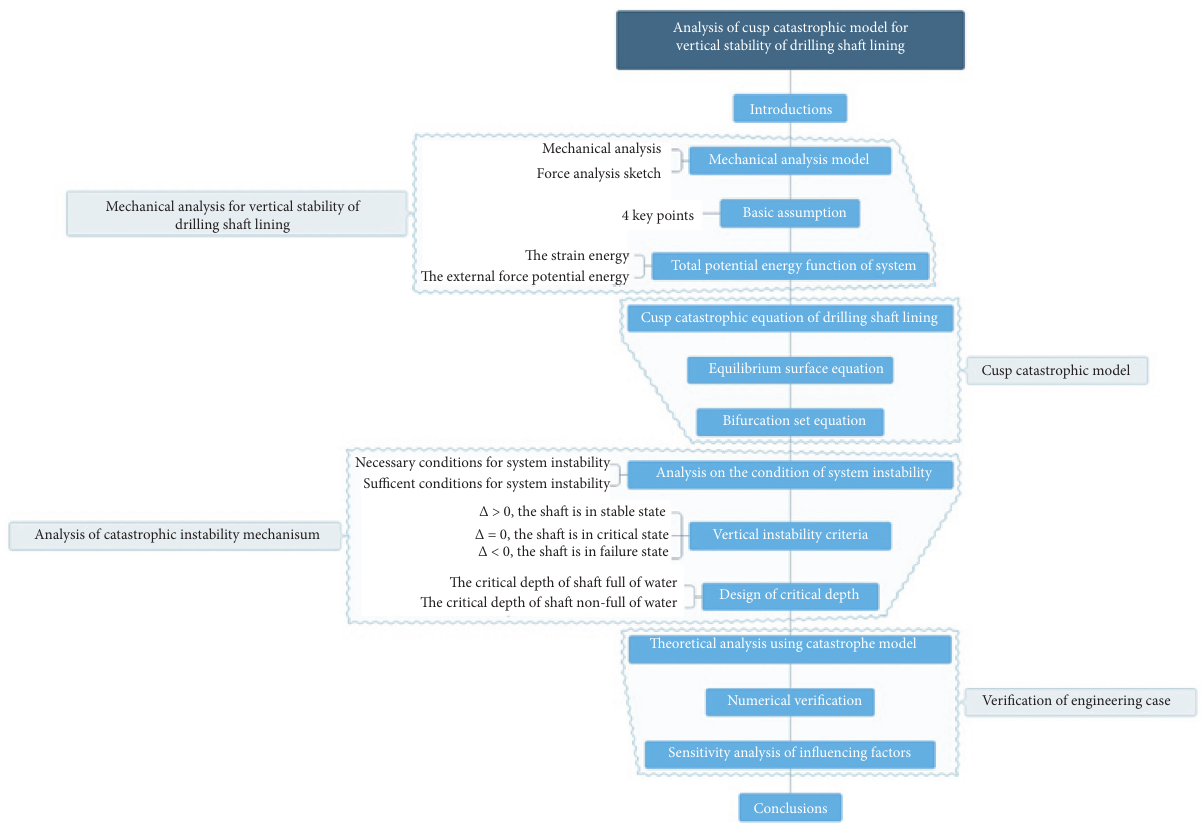
Figure 2: Content mind map of this